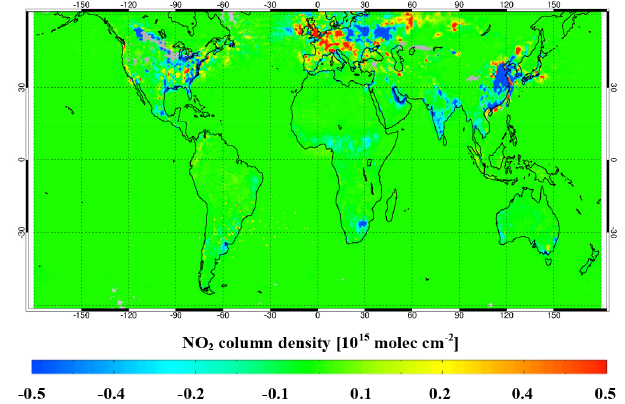
Figure 11. Difference in tropospheric NO 2 columns for clear-sky conditions (cloud radiance fraction smaller than 0.5) for February 2008 retrieved using the GOME-2 surface LER climatology ver- sion 2.1 and the LER climatology based on TOMS–GOME data at